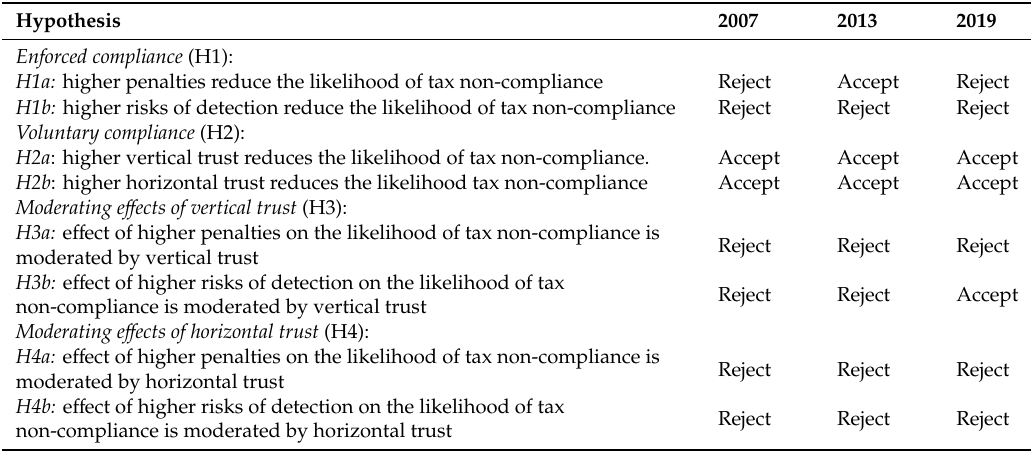
Table 4. Summary findings of